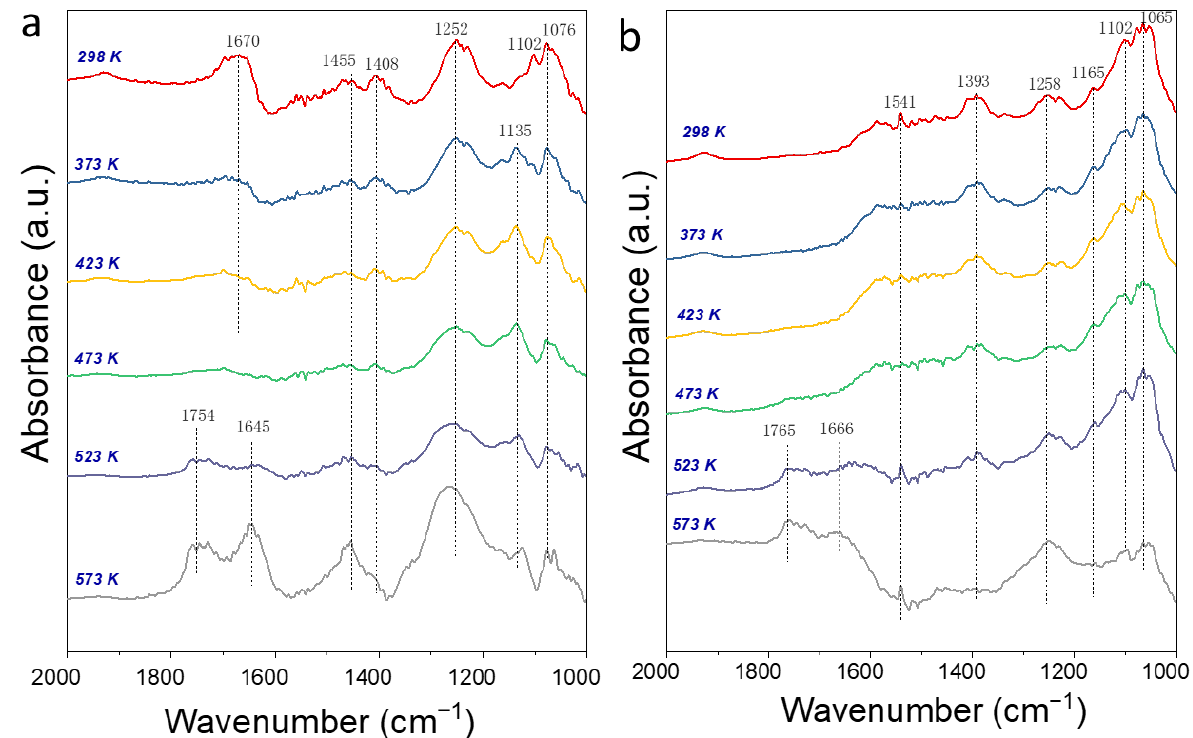
Figure 7. In situ drift spectra of ethanol adsorption and transformation on ( a ) Cu/MgAlO x and ( b ) Cu/ZnAlO x catalysts.